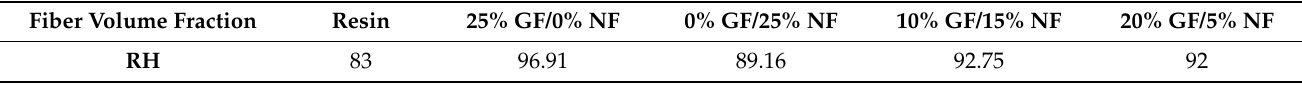
Table 6. Variation of hardness by date palm fiber